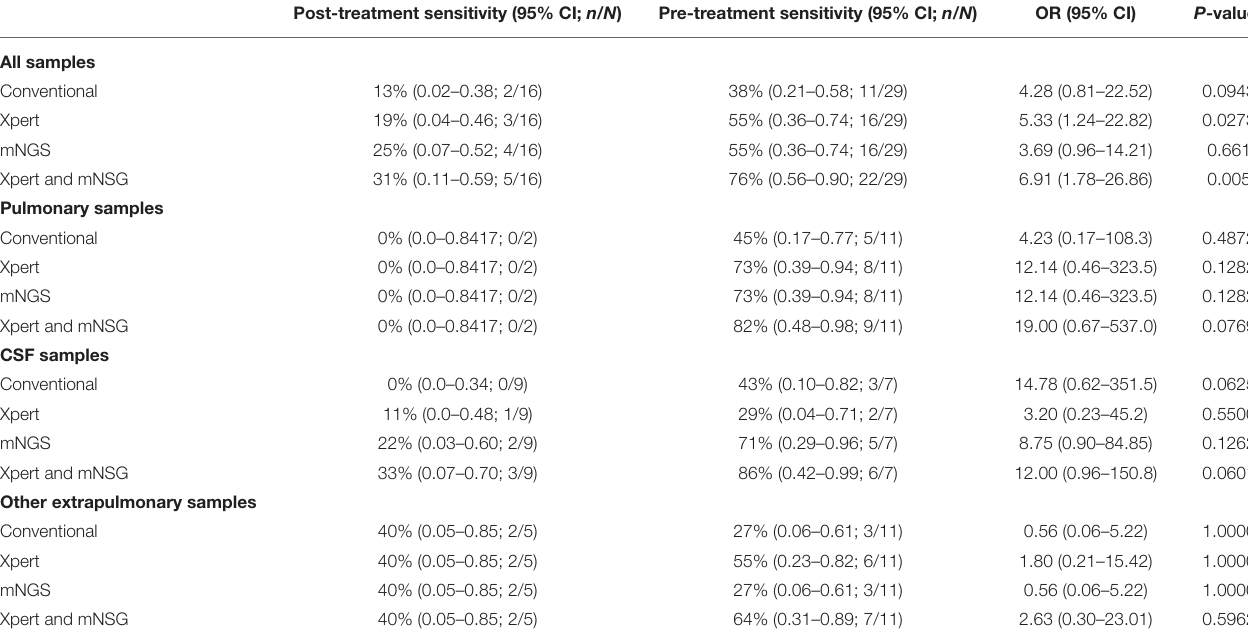
TABLE 3 | The positive diagnostic results of pre-treatment samples compared to post-treatment ones with conventional methods, Xpert, and mNGS. Post-treatment sensitivity (95% CI; n / N ) Pre-treatment sensitivity (95% CI; n / N